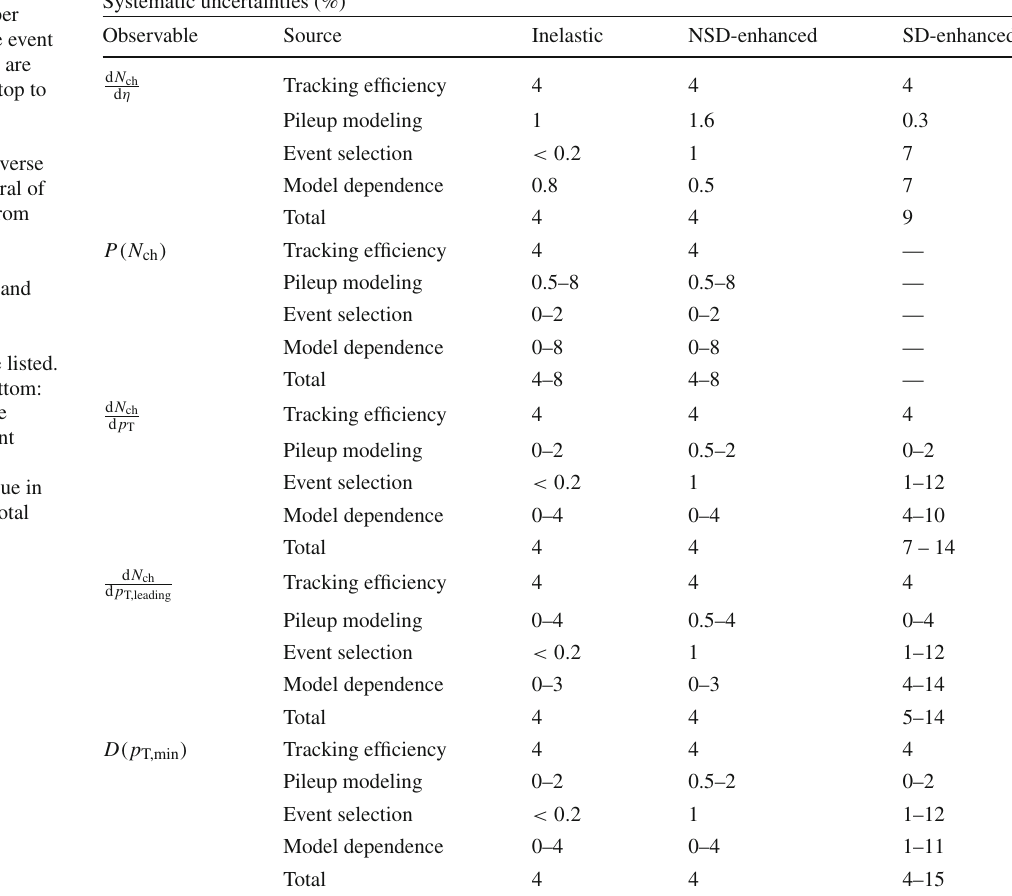
Systematic uncertainties